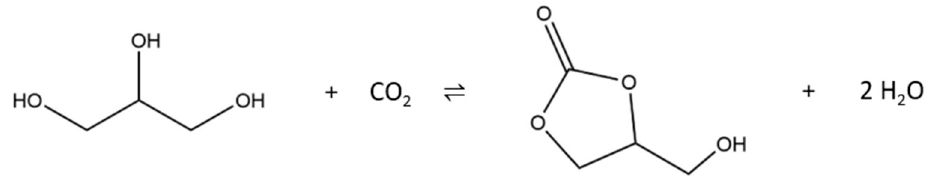
Figure 2. Reaction of glycerol with CO 2 to form glycerol carbonate and water.